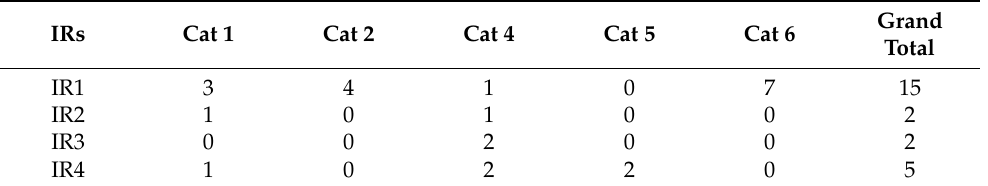
Table A3. Summary table of the negative outcomes ( N = 22) in categories (Cat 1, 2, 4, 5 and 6) a and contributed intermediate results (IRs) b